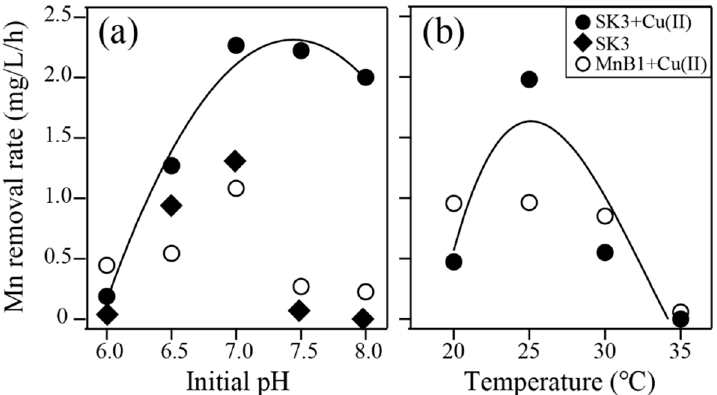
Figure 6. Mn(II) oxidative removal rates at different initial pHs ( a ) and temperatures ( b ). ● , isolate SK3 with 3 μ M Cu(II) (calculated for the time period of 0–48 h). ♦ , isolate SK3 without Cu(II) (calculated for the time period of 0–63 h). ○ , Ps. putida MnB1 with 3 μ M Cu(II) (calculated for the time period of 0–72 h). Initial conditions: [Mn(II)] = 100 mg/L; [MgSO 4 ] = 24 mg/L (originally present in